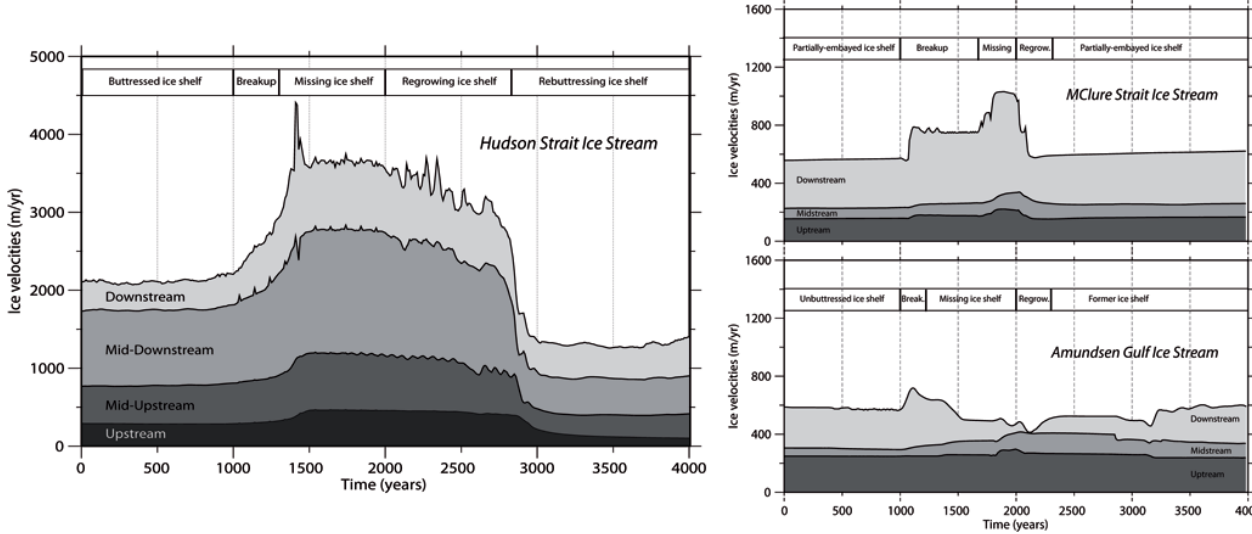
Fig. 4. Time evolution of ice velocities (in myr − 1 ) for the Hudson Strait (left), MClure Strait (top-right) and Amundsen Gulf (bottom-right) ice